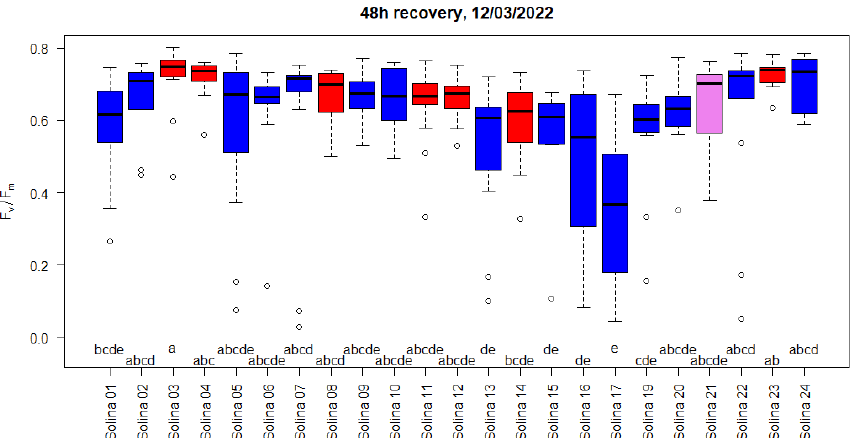
Figure 4. F v /F m , indicator of freezing damage to PSII, measured after freezing stress at −14 °C and 48h of recovery under acclimation conditions. Experiment on whole plants. The colour of the boxes indicates membership to the red and blue clusters according to De Flaviis et al. [5], with Solina 21 belonging to the blue cluster closest to the red cluster shown in purple. F v /F m did not differ signifi- cantly for accessions with the same letter according to Kruskal-Wallis test and multiple comparison with Bonferroni correction.